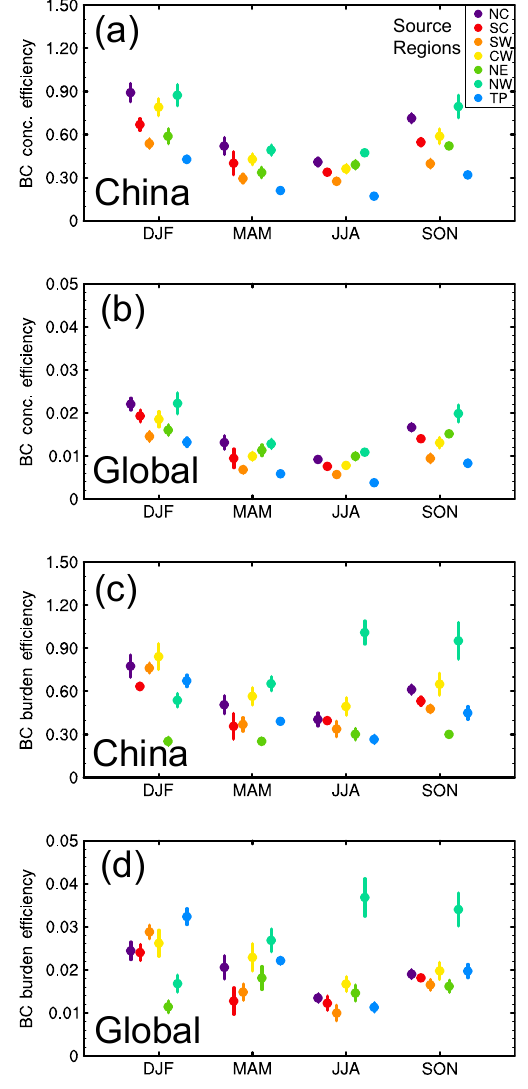
Figure 13. Seasonal (a, b) near-surface concentration (µgm − 3 Tg − 1 ) and (c, d) column burden (mgm − 2 Tg − 1 ) ef- ficiency of BC for each of the tagged source regions over China and